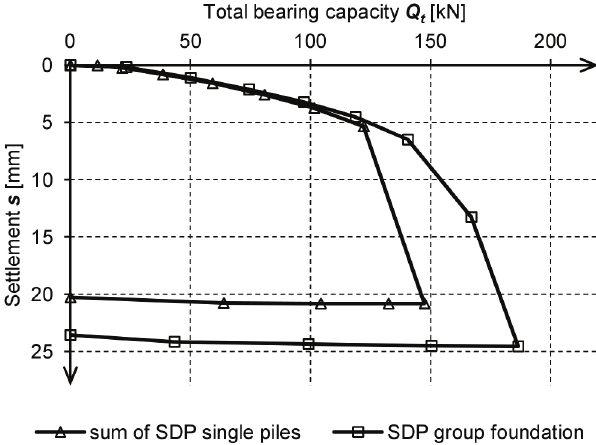
Fig. 9. Bearing capacity characteristics of SDP group foundation and sum of single SDP